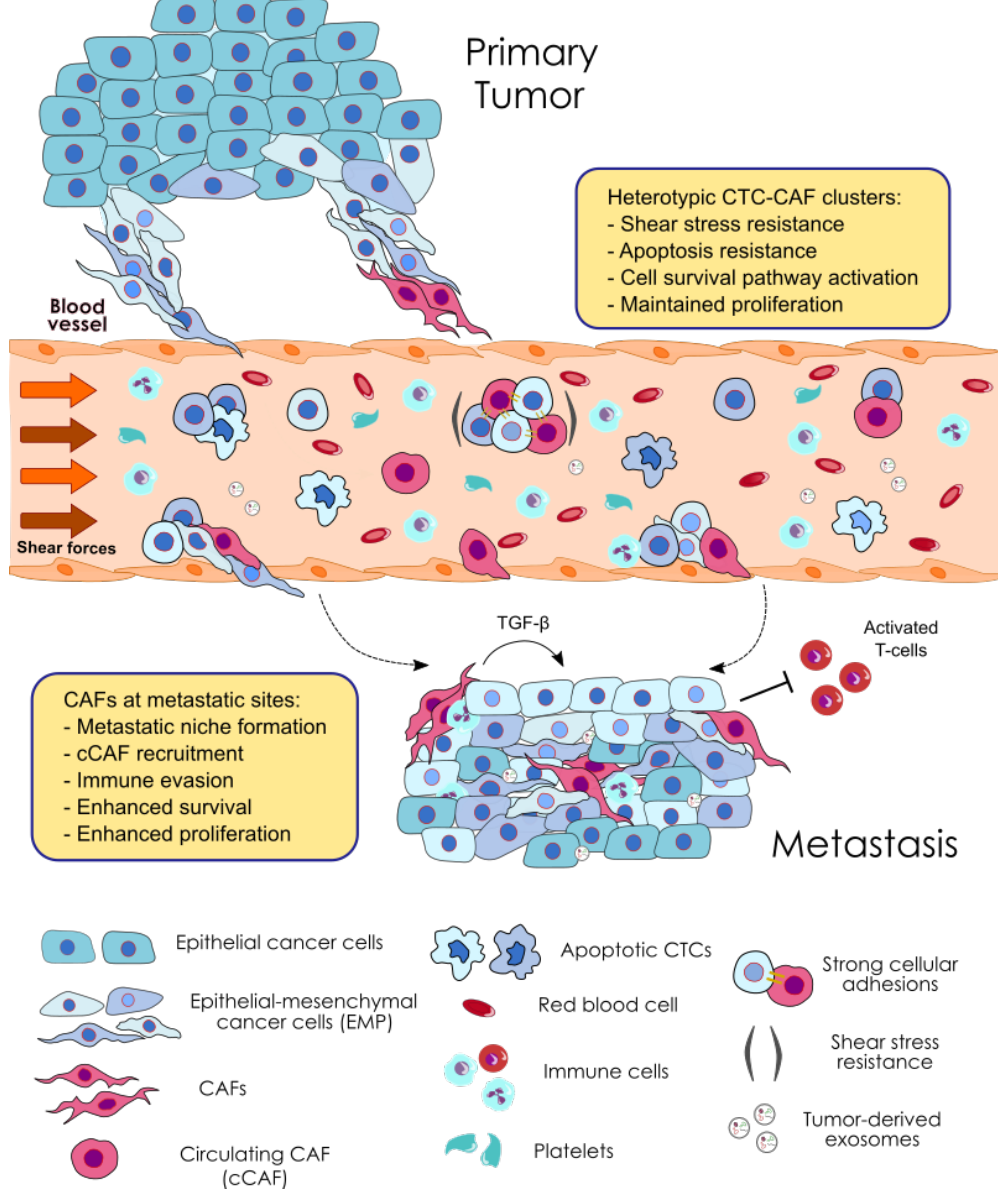
Figure 2. Pro-metastatic effects exerted by CAFs within heterotypic CTC clusters and at the secondary site. In circulation, CAFs enhance the metastatic potential of CTCs by conferring to them shear stress resistance through the establishment of strong cellular adhesions. Moreover, CAFs protect CTCs from apoptosis by activating cell survival pathways and maintaining CTC proliferation. At the metastatic site, CAF-secreted factors and tumor-derived exosomes create an appropriate environment for CTC growth, also supported by CAF-mediated immunosuppression. Additionally, circulating CAFs can be recruited to secondary sites and contribute to the establishment of the metastatic niche.